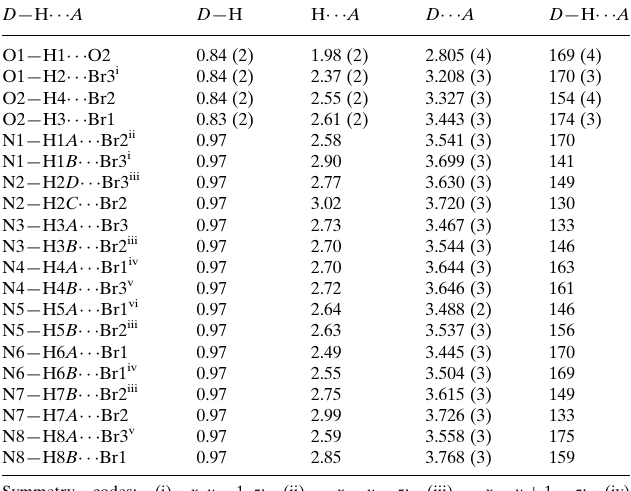
Hydrogen-bond geometry (A˚ , (cid:3)